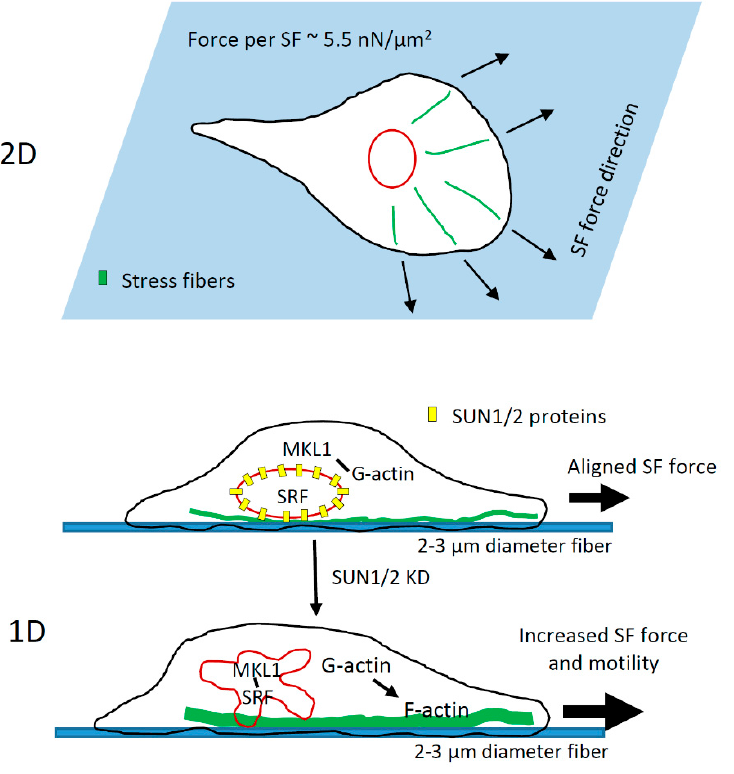
Figure 8. Model of tumor cell migration in fibrillar tumor microenvironment in vivo. During invasion, single tumor cells migrate along thin collagen fibers (2–3 µ m in diameter) with high speeds. As opposed to 2D environment, where cell spreads leading to distributed actomyosin forces (force per stress fiber ~ 5.5 nN/ µ m 2 [68,69]), in confined 1D environment, greater aligned actomyosin forces along the fiber 1D axis generate high-speed migration. This 1D high-speed migration is coupled to cell-intrinsic nuclear deformation even in the absence of any restricting ECM pores. Downregulation of LINC complex proteins (SUN1 and SUN2) in tumor cells leads to MKL1 nuclear translocation and increased SRF-MKL1 transcriptional activity, which upregulates genes for actin polymerization activity and further enhances tumor cell motility in